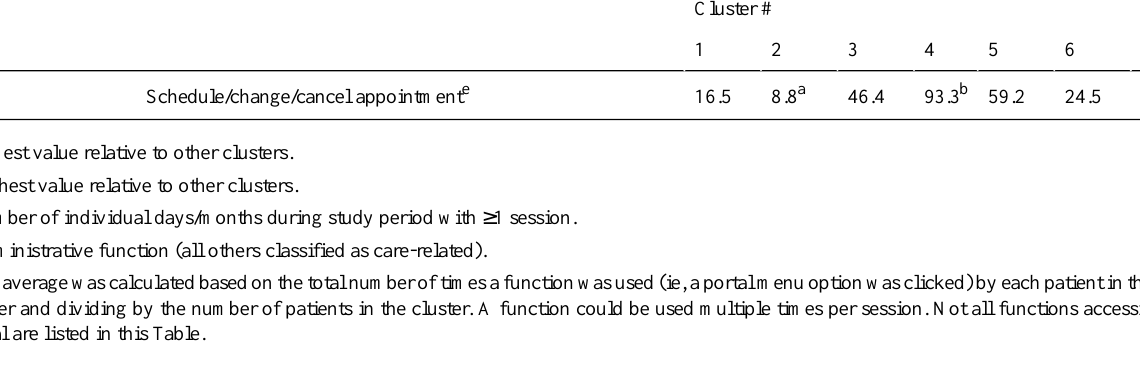
Table 4. Characteristics of patients in each of the eight clusters of user